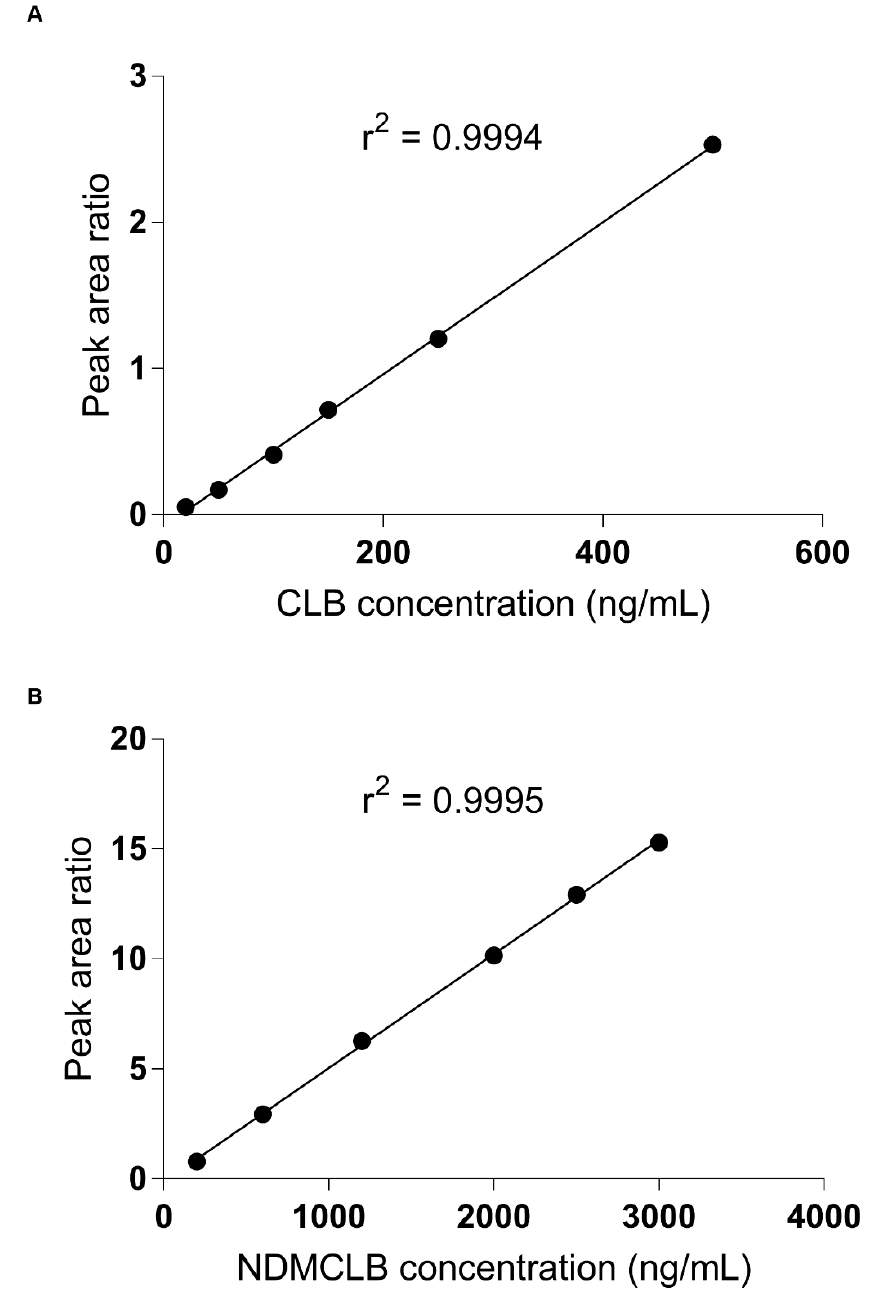
Figure 3. ( A ) Linearity of clobazam (CLB) over range 20–500 ng/mL; ( B ) linearity of N - desmethylclobazam (NDMCLB) over range 200–3000 ng/mL.